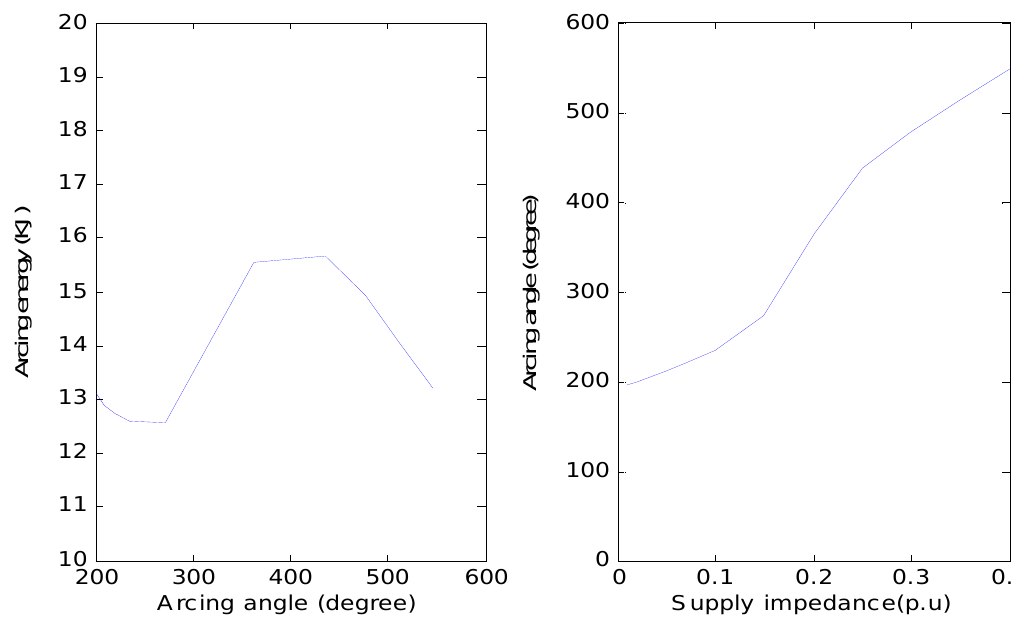
Figure 9. Variation of the arc energy versus arc-angle and arc-angle versus the supply impedance when the 200 A fuse used as F1.